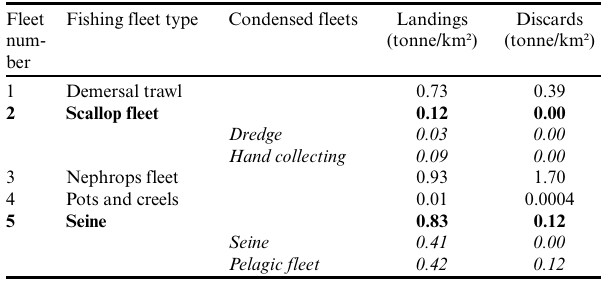
Table 7. Fishing fleet structure, landings, and discards for the marine spatial planning challenge Clyde Sea Ecopath with Ecosim model. Fleets that include more than one of the fleets from the uncondensed Clyde Sea model are in bold font and their components are in